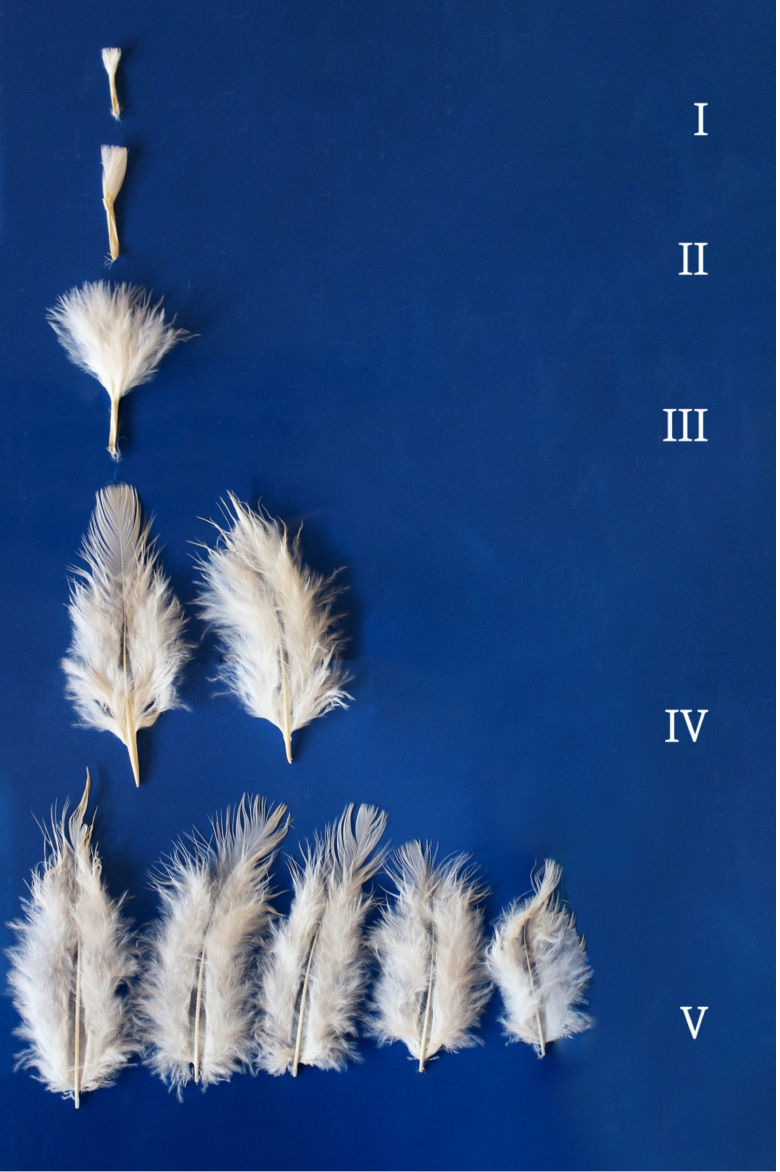
Figure 3. Thigh feathers in a 16-week-old turkey. Feather growth stages: I—pinfeather covered in sheath; II—barbs protruding from the sheath; III—feather unsheathed by 1 / 2 of rachis length; IV—plumulaceous (loose) vane and pennaceous (coherent) vane, feathers unsheathed by 3 / 4 of rachis length; V—mature feathers, feather length: shortest—3.5 cm, longest—5.0 cm, afterfeathers and empty spaces between